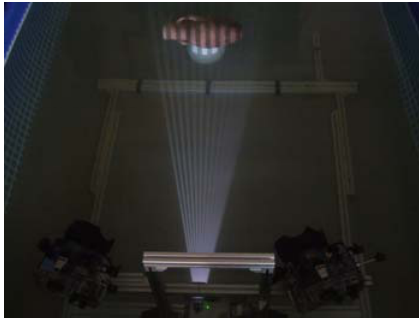
Figure 4. Passive acquisition in water tank.